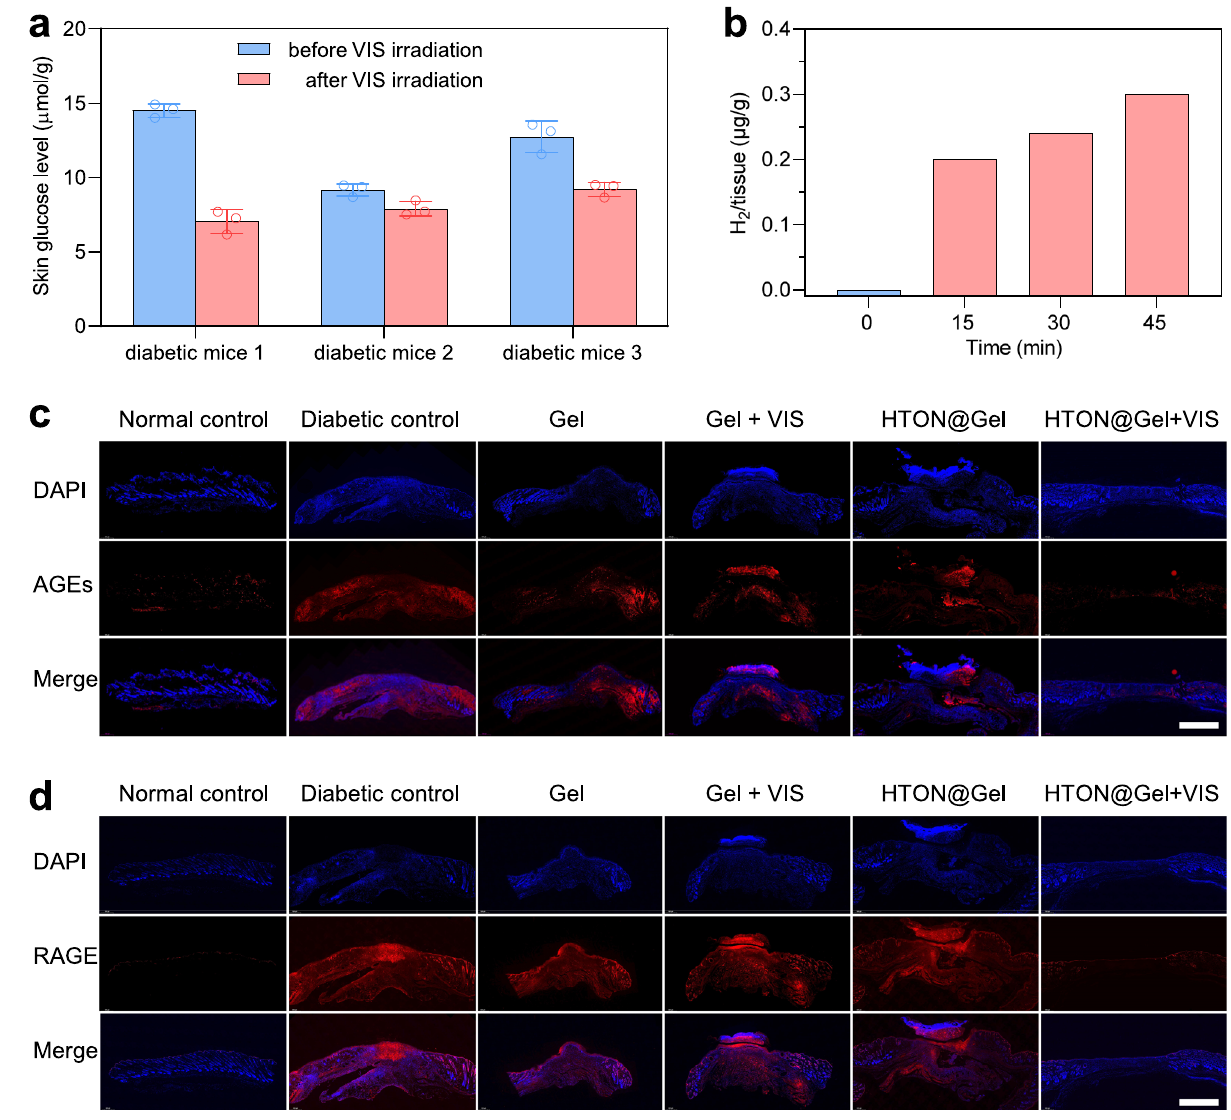
Fig. 6 | The effect of HTON-mediated photocatalytic therapy on in vivo AGEs and RAGE expression at the site of diabetic wound. The concentrations of glu- cose ( n =3 biologically independent samples) ( a ) and H 2 ( b ) before and after VIS irradiation at the site of diabetic wound, and immuno fl uorescence images of wound tissues extracted at day 14 for determining the expression of advanced